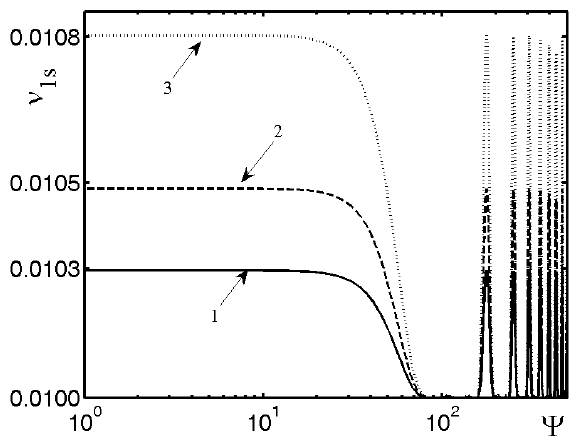
Figure 10: The spectral width (1 st moment) of the power spectrum for different orientation angle of elongated plasma / 2 k V n p= . Curve 1 corresponds to the field-aligned x plasma irregularities